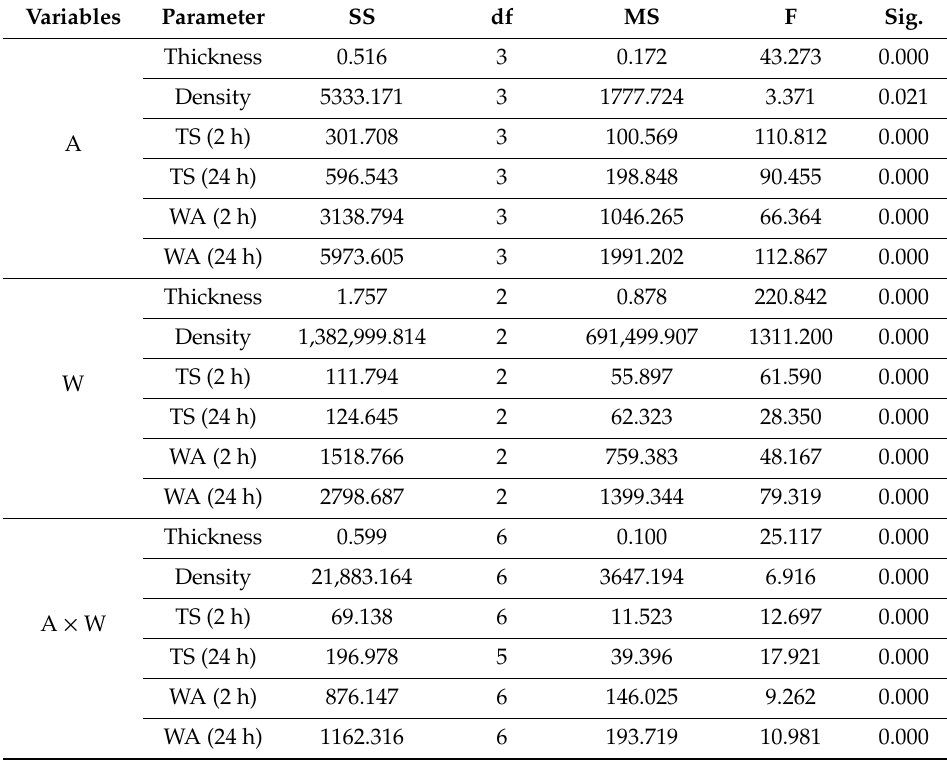
Table A1. ANOVAs of the variable parameters on the physical properties of plywood panels. Variables